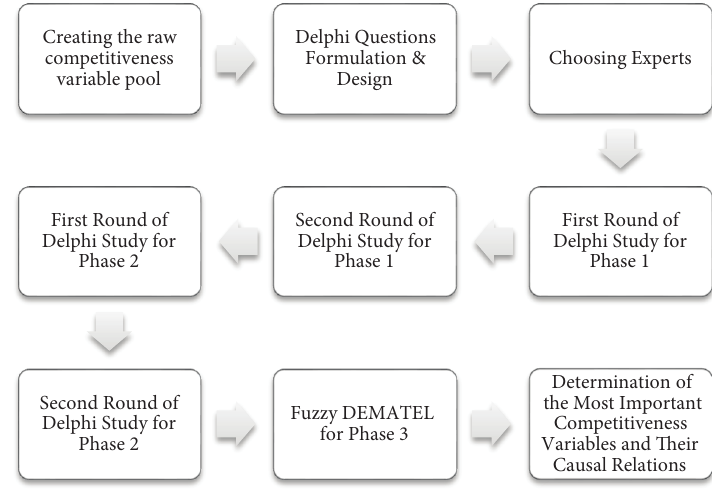
Figure 1. Basic flow diagram of the proposed